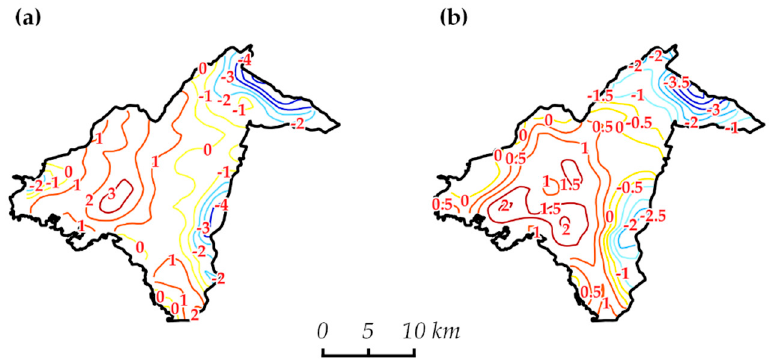
Figure 9. As in Figure 8, showing the isopleths of the difference to the average LST of the total study ≈ 14.30 local time and ( b ) ≈ 02.30 local time. area, ( a ) ≈ 14.30 local time and ( b ) ≈ 02.30 local time. area, ( a )